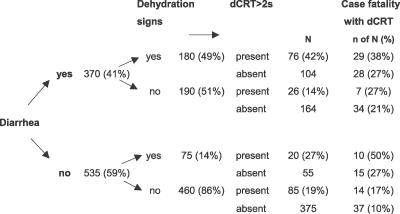
Value of the Signs of Dehydration and Delayed Capillary Refill Time (dCRT) in 905 Severely Malnourished Children with and without DiarrhoeaDiarrhoea is defined as more than three watery motions per 24 hours. “Dehydration signs” are sunken eyes and/or decreased skin turgor.